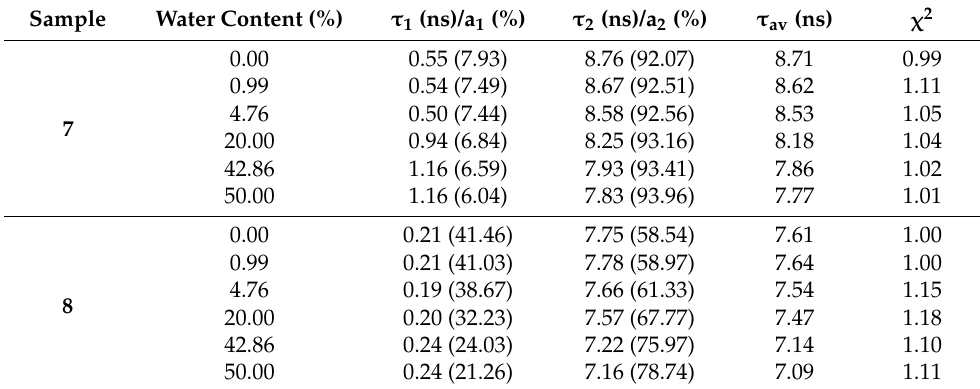
Table 9. Fluorescence lifetimes of naphthalimides in DMF/water mixtures.